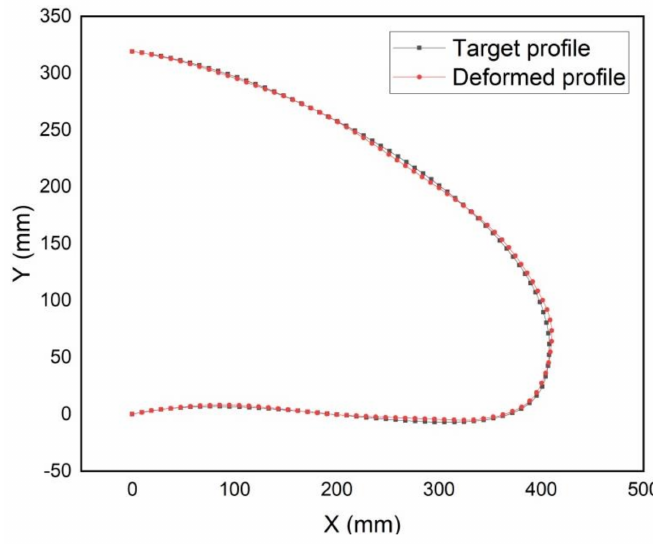
Figure 10. Comparison between target profile and deformed profile.